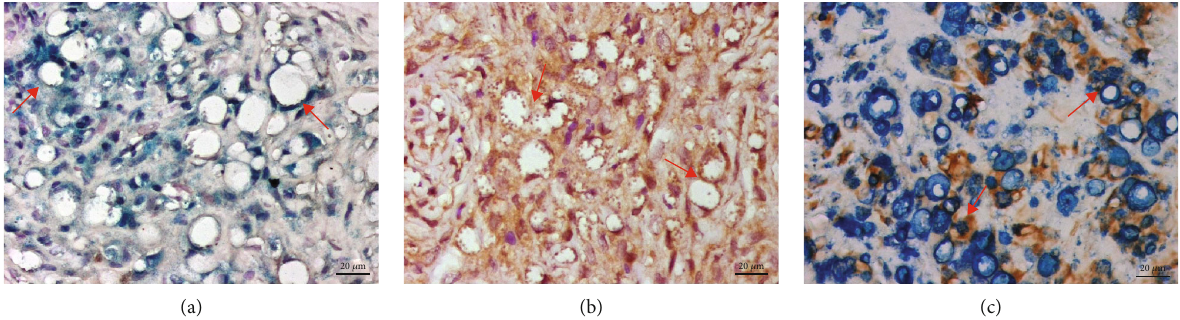
Figure 2: Histological sections of the skin lesion from anergic di ff use cutaneous leishmaniasis (ADCL) processed by double-staining immunohistochemistry showing (a) CD163 + cells (blue), (b) IL-10 + cells (brown), and (c) M2 macrophages (CD163 + /IL-10 + ) ( × 400). The red arrows show immunostained cells for the di ff erent